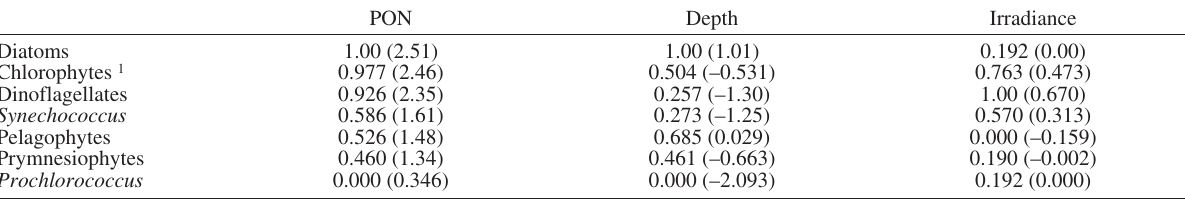
Table 1. – Normalized means (non-normalized values in brackets for PON and depth) weighted by the different phytoplankton groups (see text in the M&M section for details). For irradiance the value in brackets is the difference between normalized PON and Depth; this differ- ence (irradiance) is then normalized to the 0 to 1 range (no brackets). Weighted means of particulate organic nitrogen (PON, µmol L –1 ) from Latasa et al. (2010). Weighted means of depth distribution along the upper part of the DCM layer (m) from Cabello